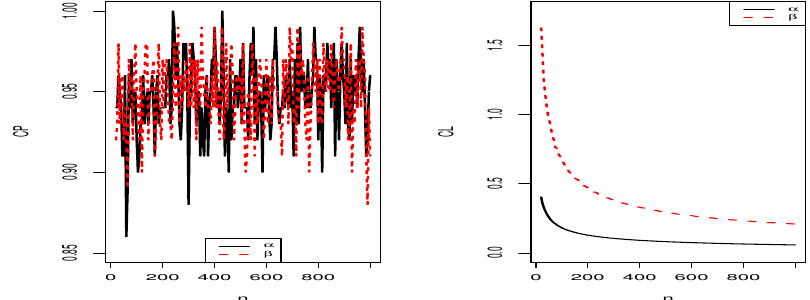
Figure 9. The empirical CLs and CPs of the MLEs for the